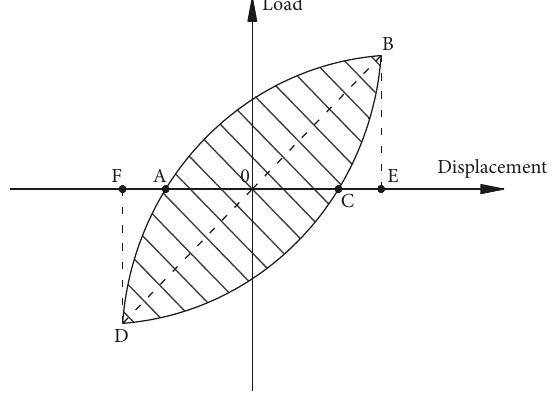
Figure 8: Calculation